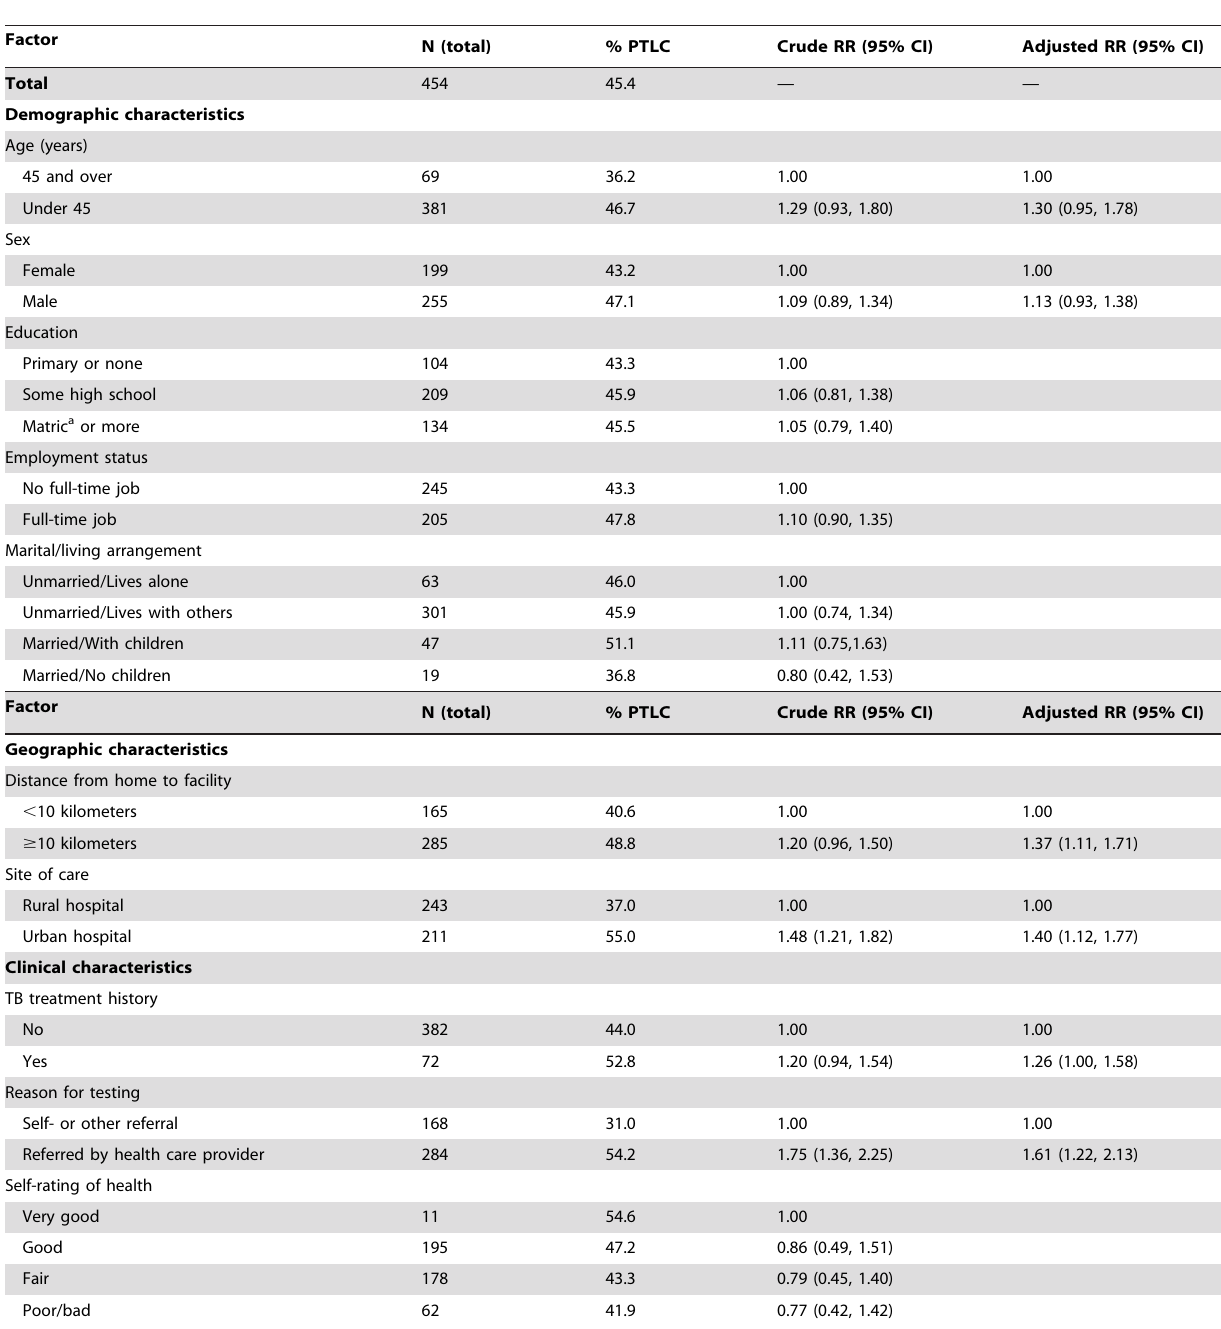
Table 2. Factors associated with pre-treatment loss to care after HIV diagnosis in a cohort of newly diagnosed HIV-infected persons in two PEPFAR sites, Durban, South Africa,